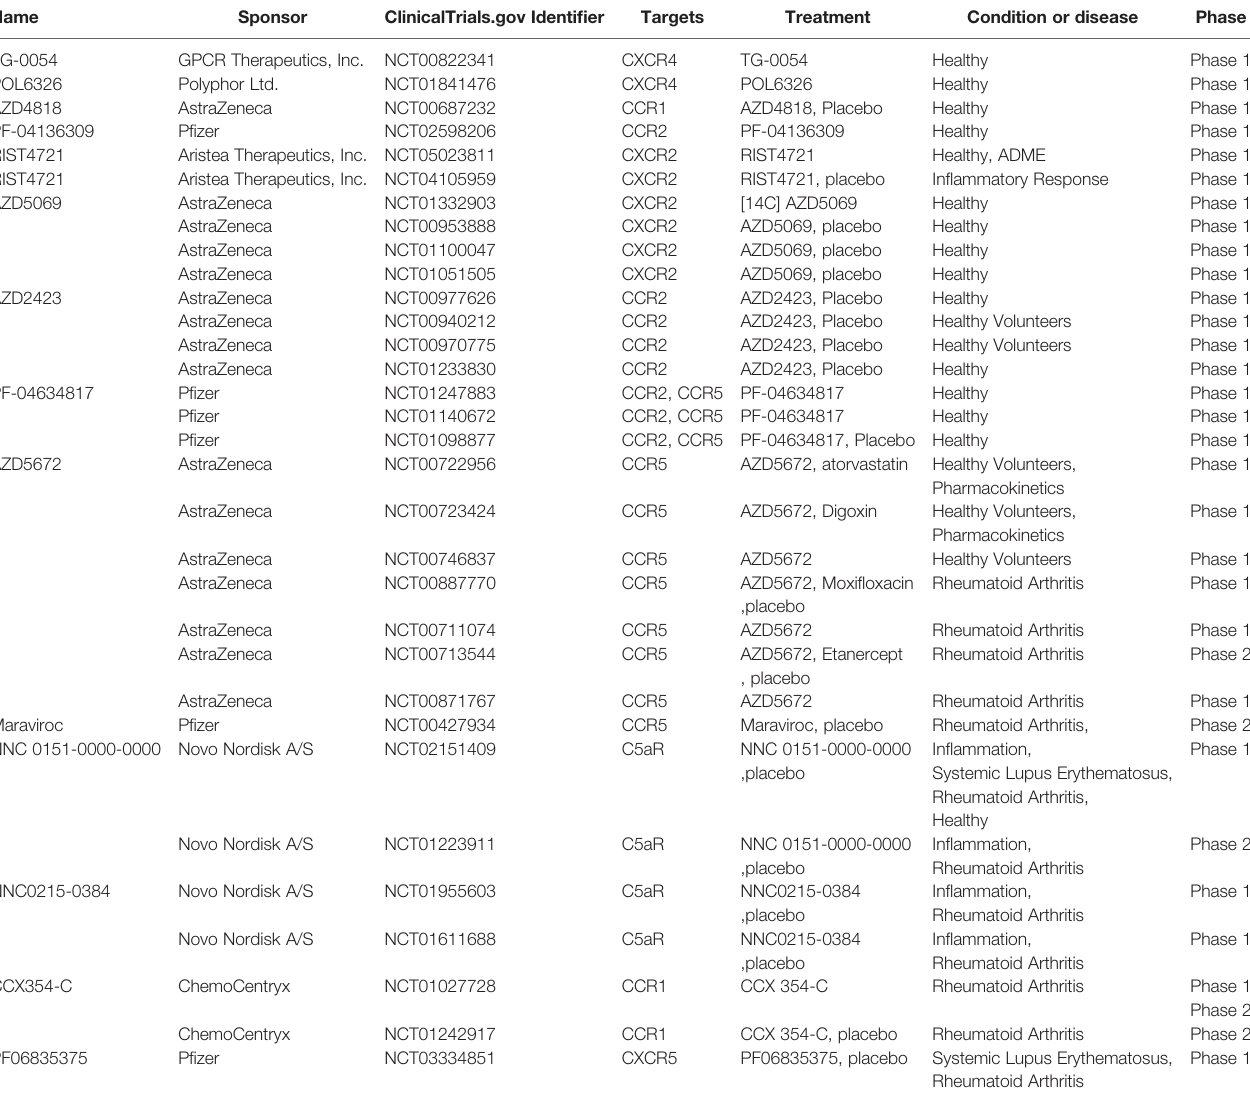
TABLE 2 | Clinical trials of GPCR related to